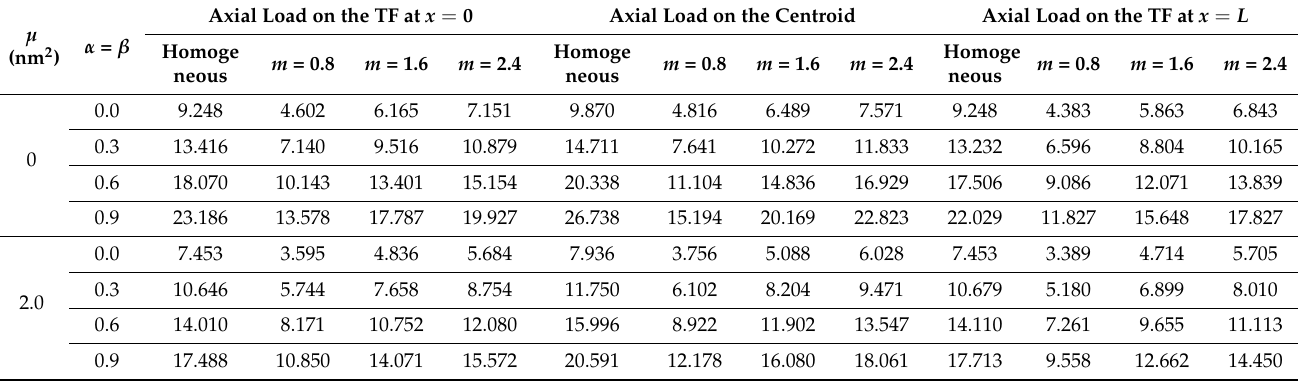
Figure 4. Variation in the flexural buckling load P nor of I-tapered nanobeams with variations in the tapering and nonlocality parameters for different material indexes (axial load on the centroid) ( a ) Homogeneous ( Alumina ) ; ( b ) m = 0.6; ( c ) m = 1.3; ( d ) m = 2. Table 2. Effect of the axial load eccentricity, material graduation and tapering parameter on the normalized buckling load ( P nor ) for simply supported thin-walled nanobeams subjected to a constant compressive load with two different nonlocal parameters.